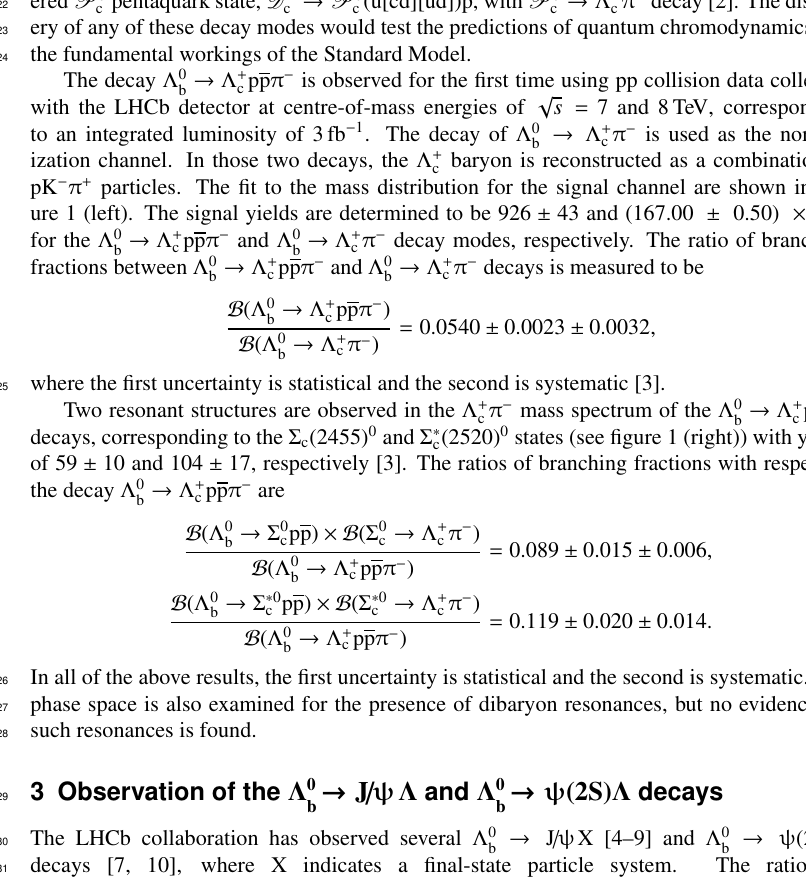
Figure 1. Mass distributions of the (left) Λ 0 Λ + π − decay. The Σ c (2455) 0 and Σ ∗ the Λ 0 c pp b → shown as a blue continuous line, with the background component due to random combinations